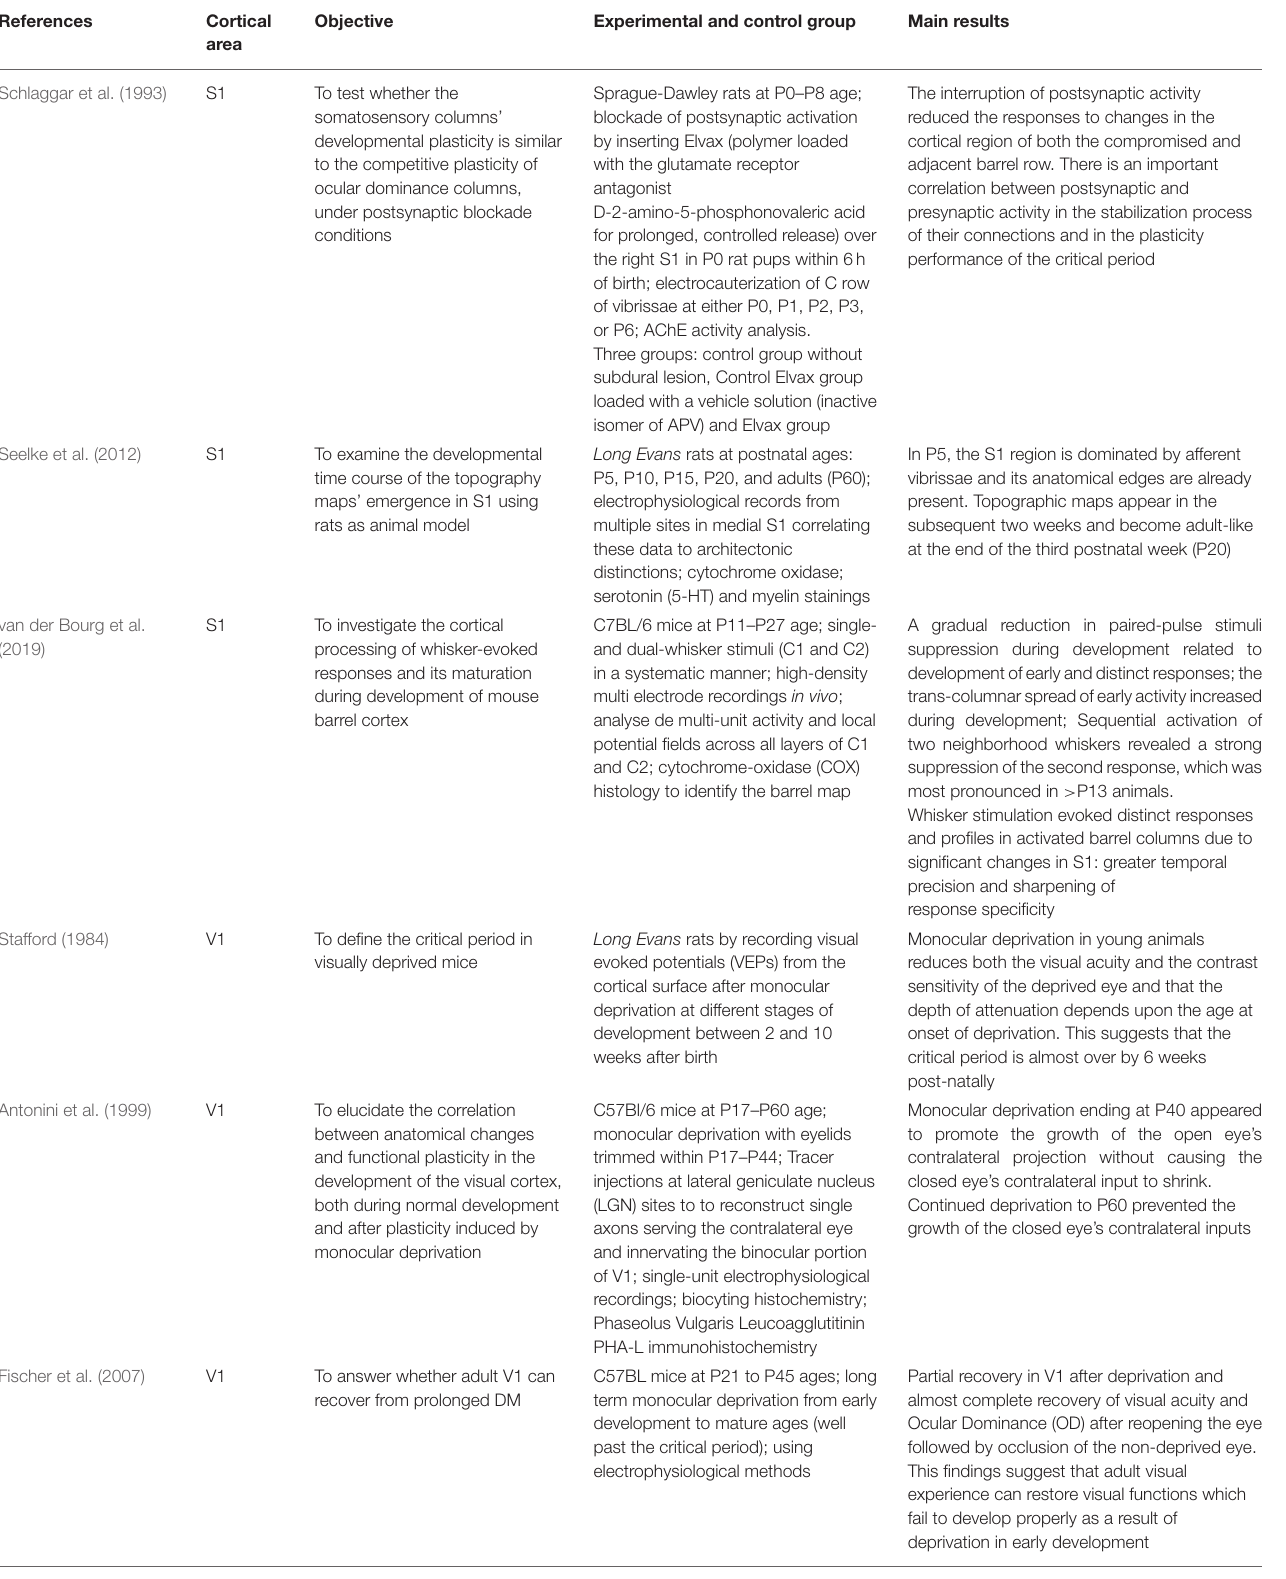
TABLE 1 | Results of individual studies and synthesis of